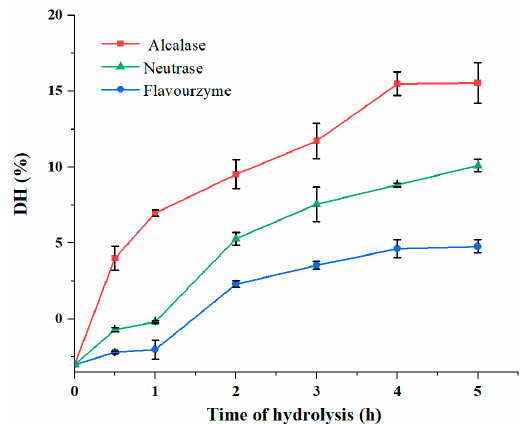
Figure 1. Degree of hydrolysis (DH) of DDSG-PI hydrolysates treated by three proteolytic enzymes.